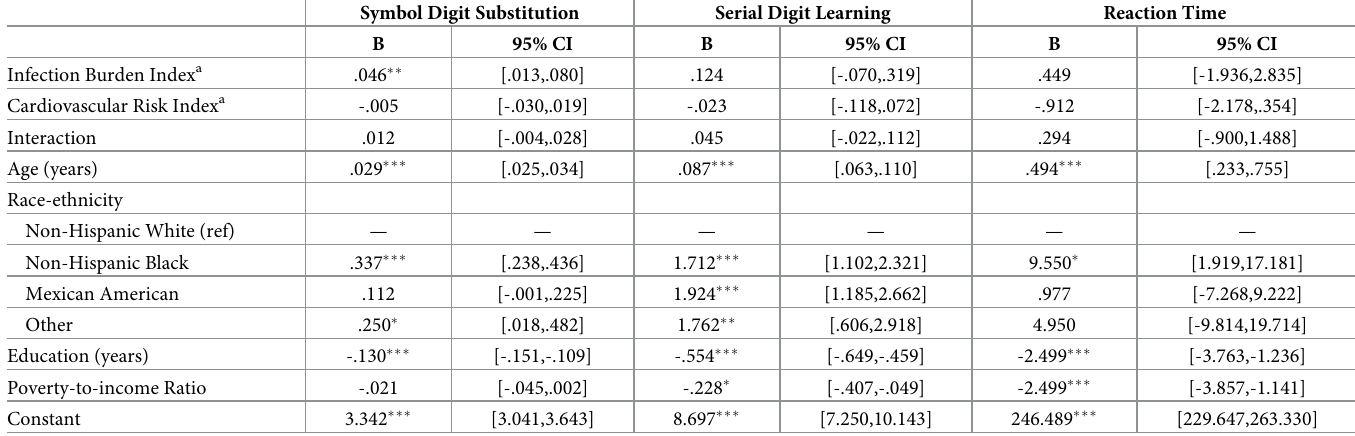
Table 4. Interaction effects between an infection-burden index and cardiovascular-risk index and associations with cognitive function in male U.S. adults aged 20 to 59 years.